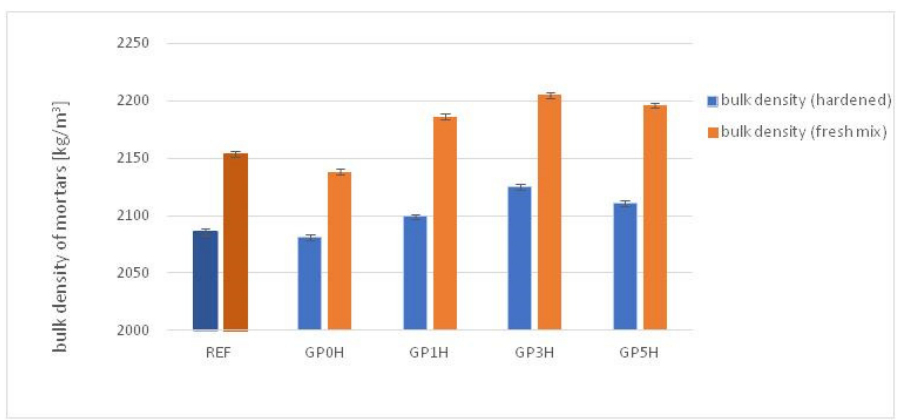
Figure 4. Effect of replacing the cement with the granite powder on bulk density of cementitious composites.